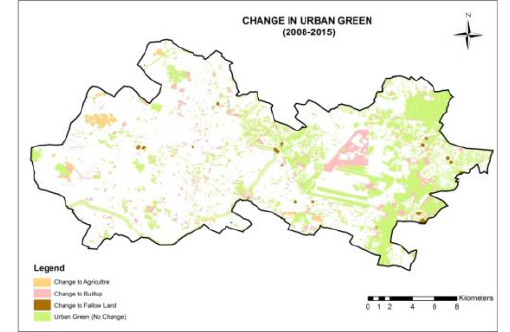
Figure 7: Change in Urban Green (2008-15)